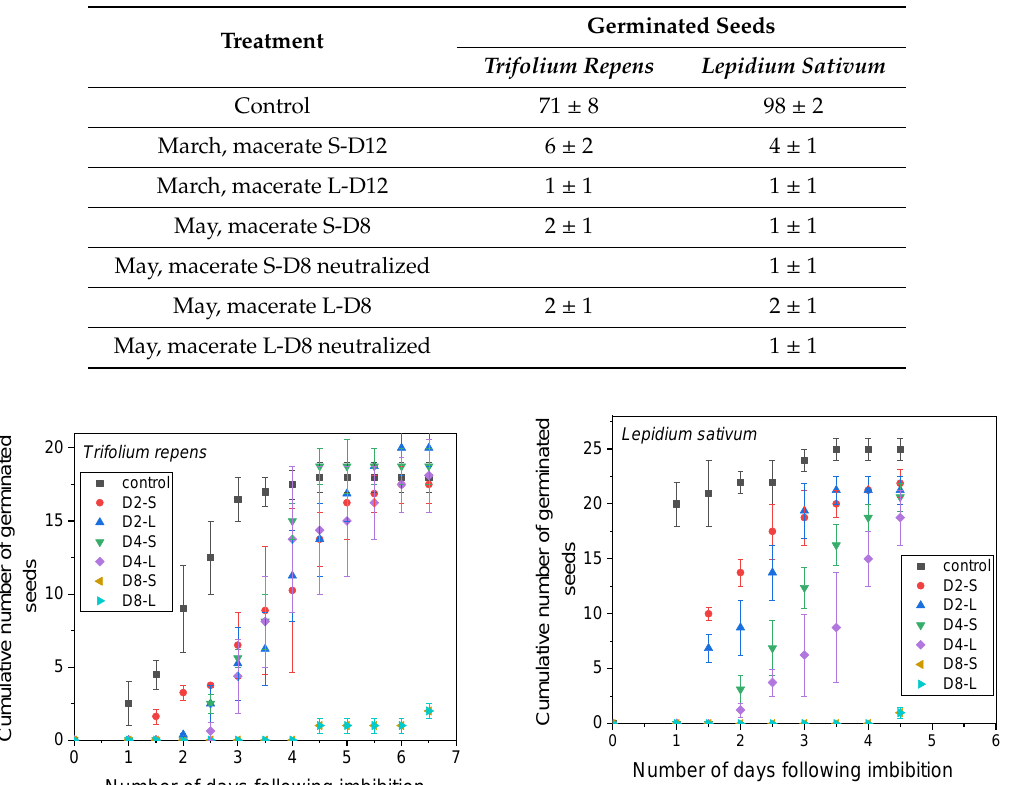
Figure 1. Germination dynamics of Trifolium repens ( left ) and Lepidium sativum ( right ) seeds in macerates prepared with leaves collected in May on trees facing north (S) or exposed to solar light (L). The germinated seeds are counted each day during the 7 days following the imbibition. Points represent mean values of four replicates ( ± standard error). Table 1. Number of germinated seeds for different treatments at 7 days post imbibition.